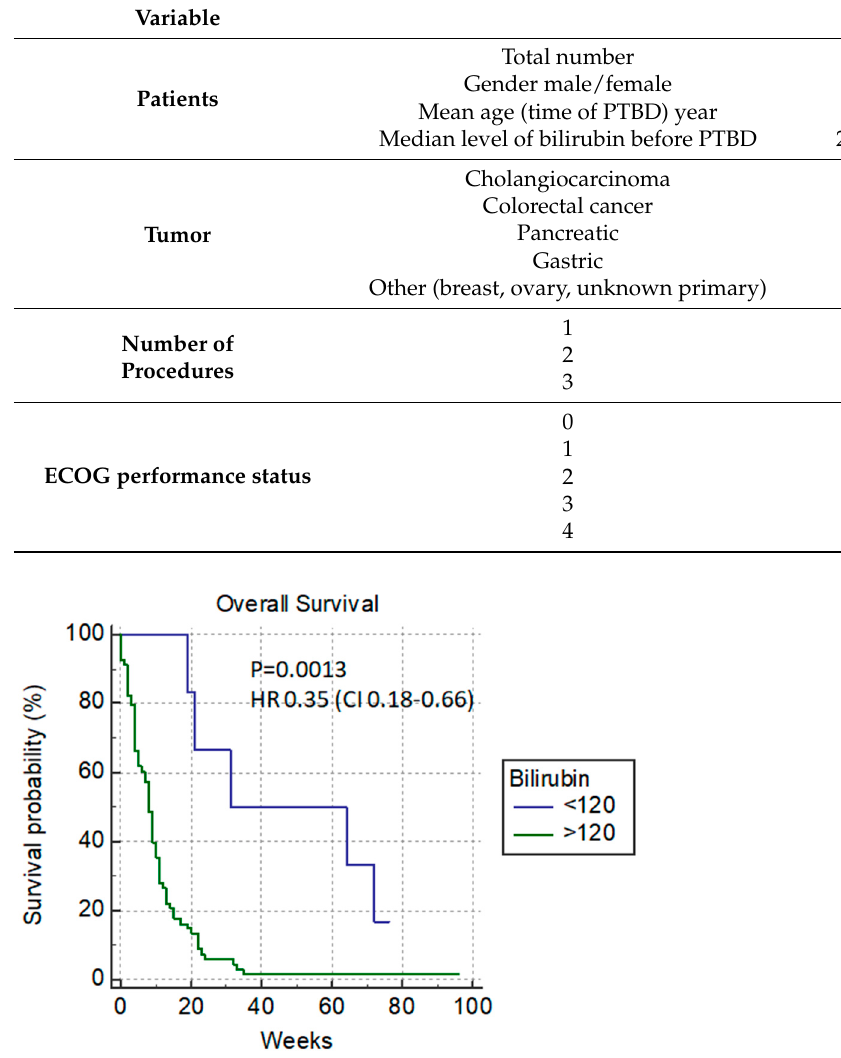
Figure 2. Overall survival versus bilirubin cut-off level of 120 µmol/L.